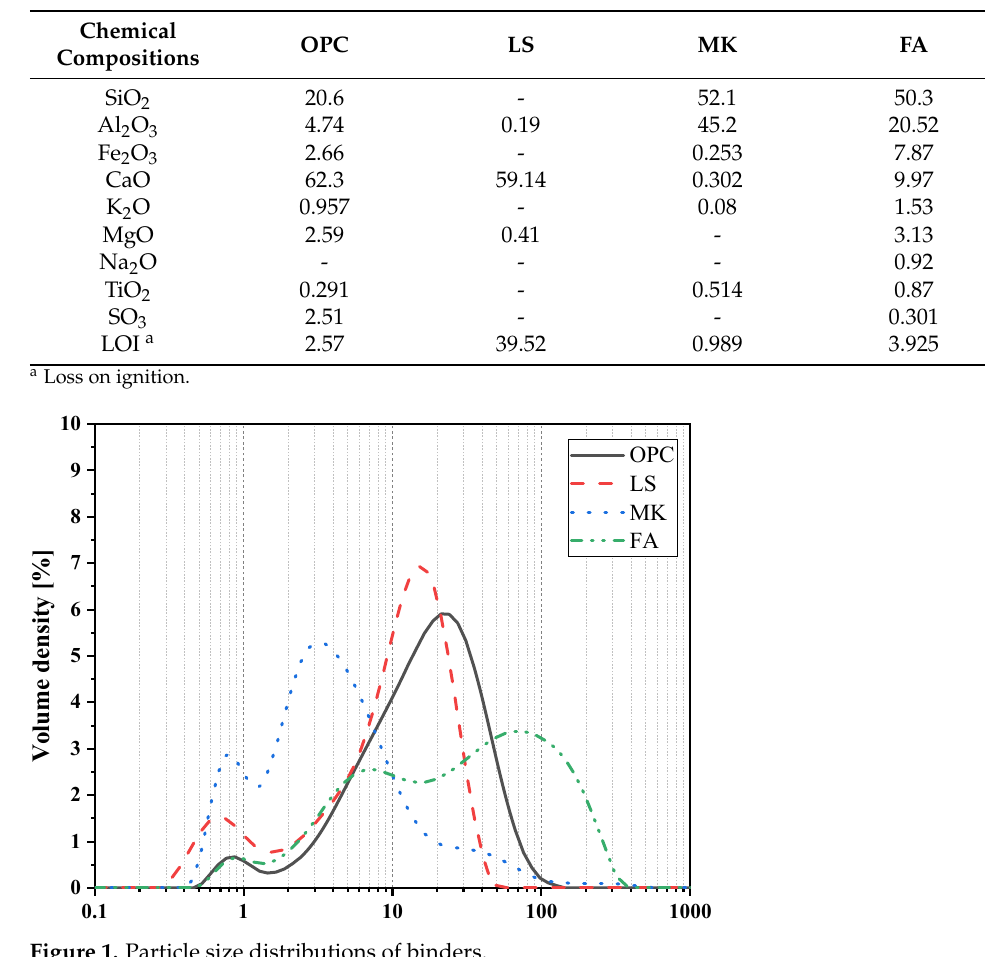
Table 1. Chemical compositions of materials in weight % (OPC: ordinary Portland cement; LS: limestone powder; MK: metakaolin; FA: fly ash).